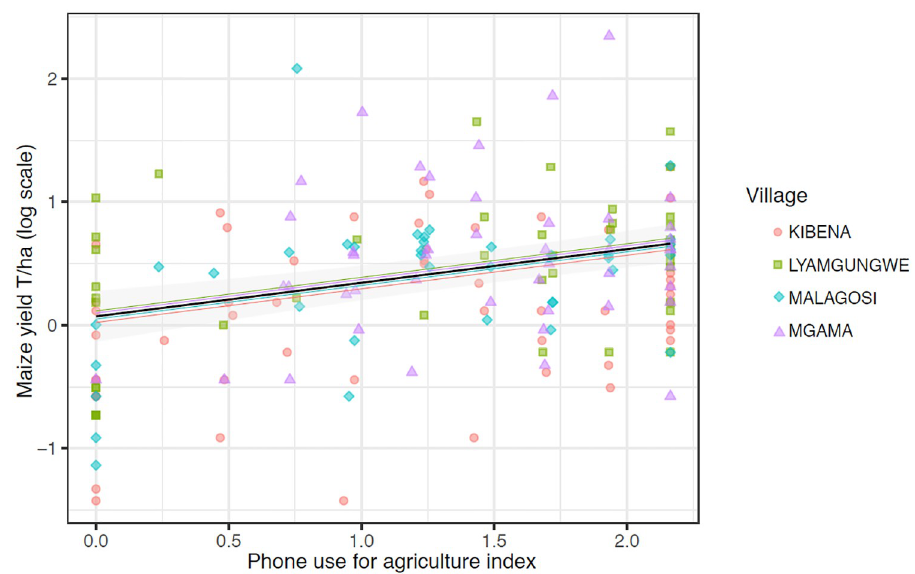
Fig 3. Phone for agriculture model estimates for the predicted association between reported maize yield outcomes and the degree to which farmers integrate phones into agricultural activities (RQ3). A synthetic variable representing degree of phone use for agricultural activities was created from household survey responses by non-linear principal components analysis. Phone use for agriculture has a positive association with self-reported maize yield, after controlling for individual-level wealth, gender, farm size, age, and education. The model is estimated with varying intercept effects at the household and village levels; village intercepts are plotted as colored lines in colors corresponding to village data points. The phone use coefficient is plotted with 95% confidence intervals, with other fixed effect variables held at mean or modal values, and with averaging over uncertainty estimated across the model. See Table 4 for model